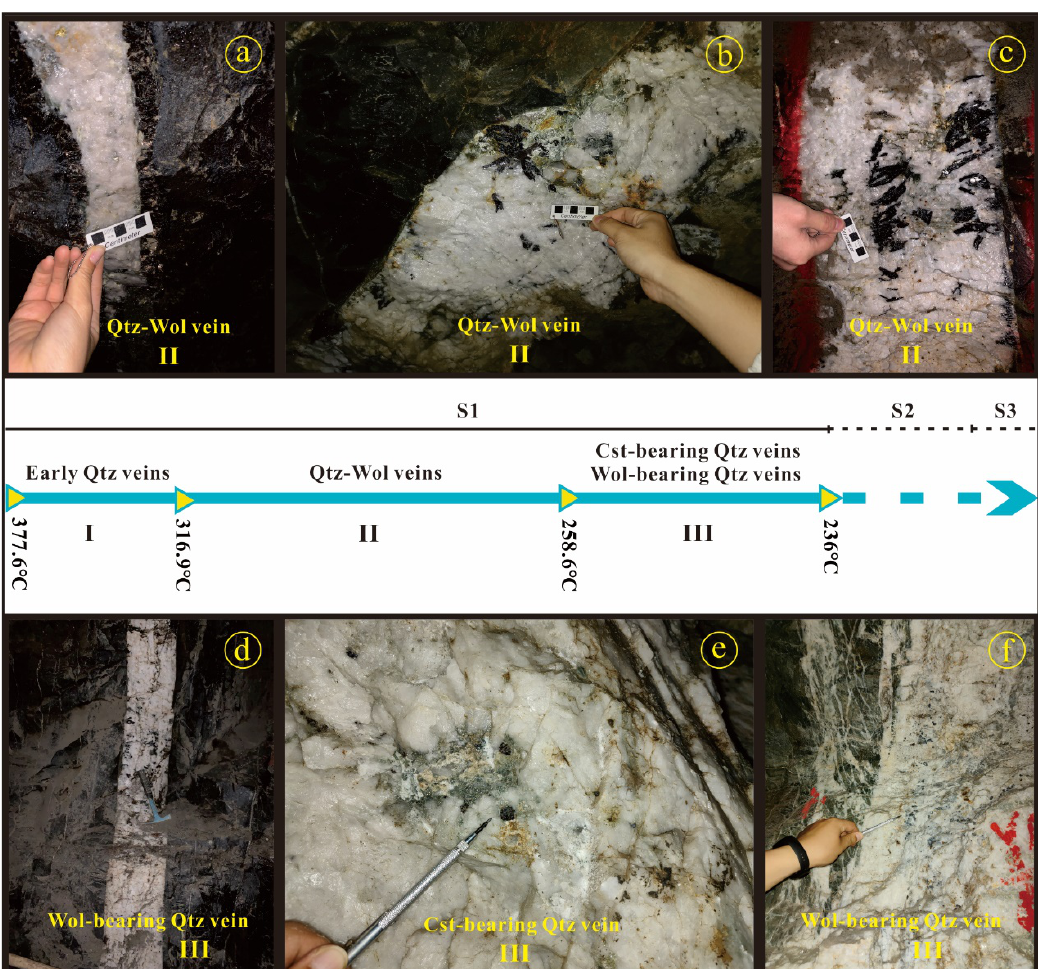
Figure 15. Deposition timeline of wolframite in the S1 mineralization stage. ( a – c ) Quartz-wolframite veining; ( d , f ) wolframite-bearing quartz veining; ( e ) cassiterite-bearing quartz veining.